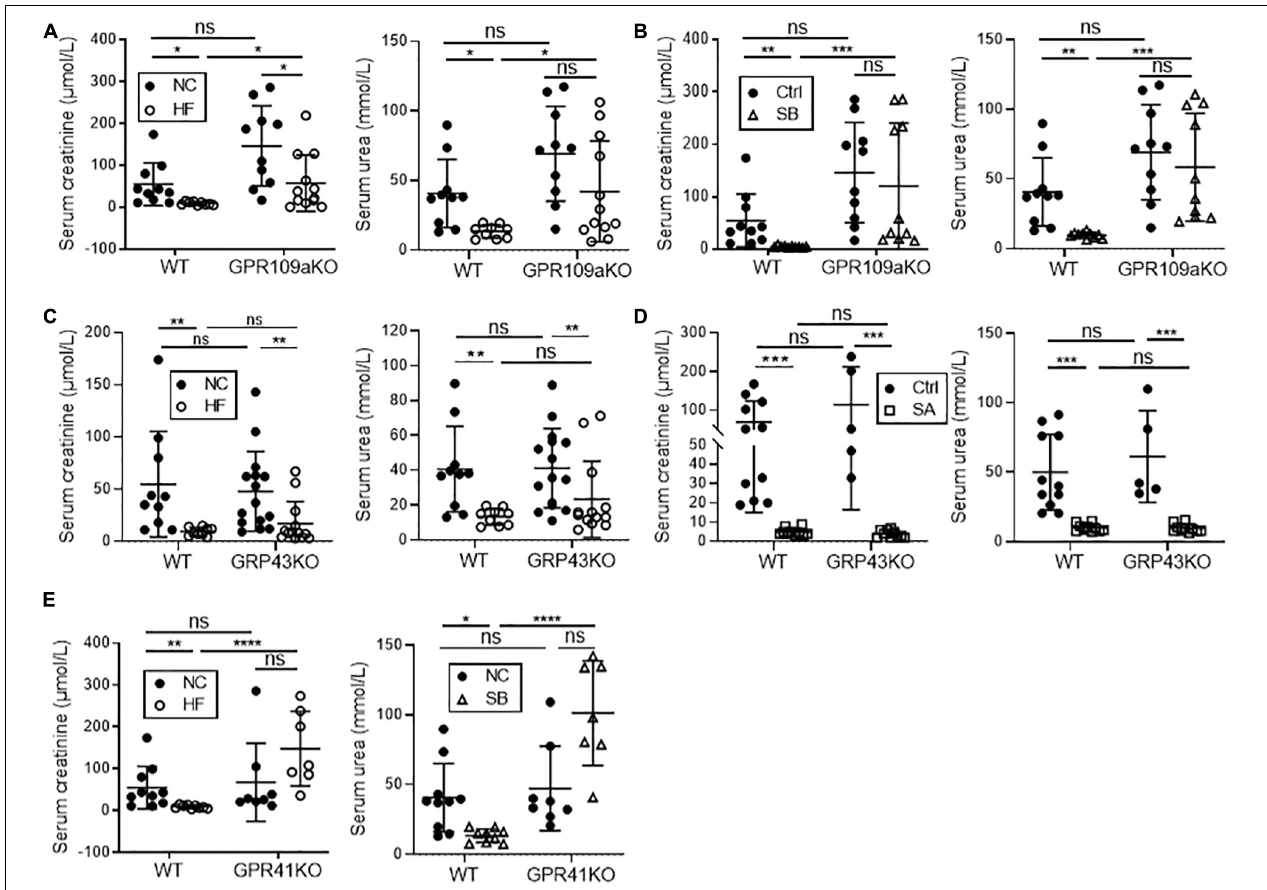
FIGURE 7 | GPR41 and GPR109a play roles in fiber and SCFA mediated reno-protection in FAN at day 2. HF diet provided partial protection against FAN in Gpr109a - / - mice (A) , however butyrate treatment did not improve renal function at day 2 (B) with no significant difference in serum creatinine or BUN compared to WT controls. Both HF diet and oral acetate treatment provided full protection against AKI in Gpr43 - / - FAN mice (C,D) . HF feeding in Gpr41 - / - FAN mice did not improve renal function at day 2, with no reduction in serum creatinine or BUN compared to WT controls (E) . FAN ( n = 6–12); non-FAN ( n = 5). Data are shown as means ± SD; * P < 0.05, ** P < 0.01, *** P < 0.001, **** P < 0.0001.